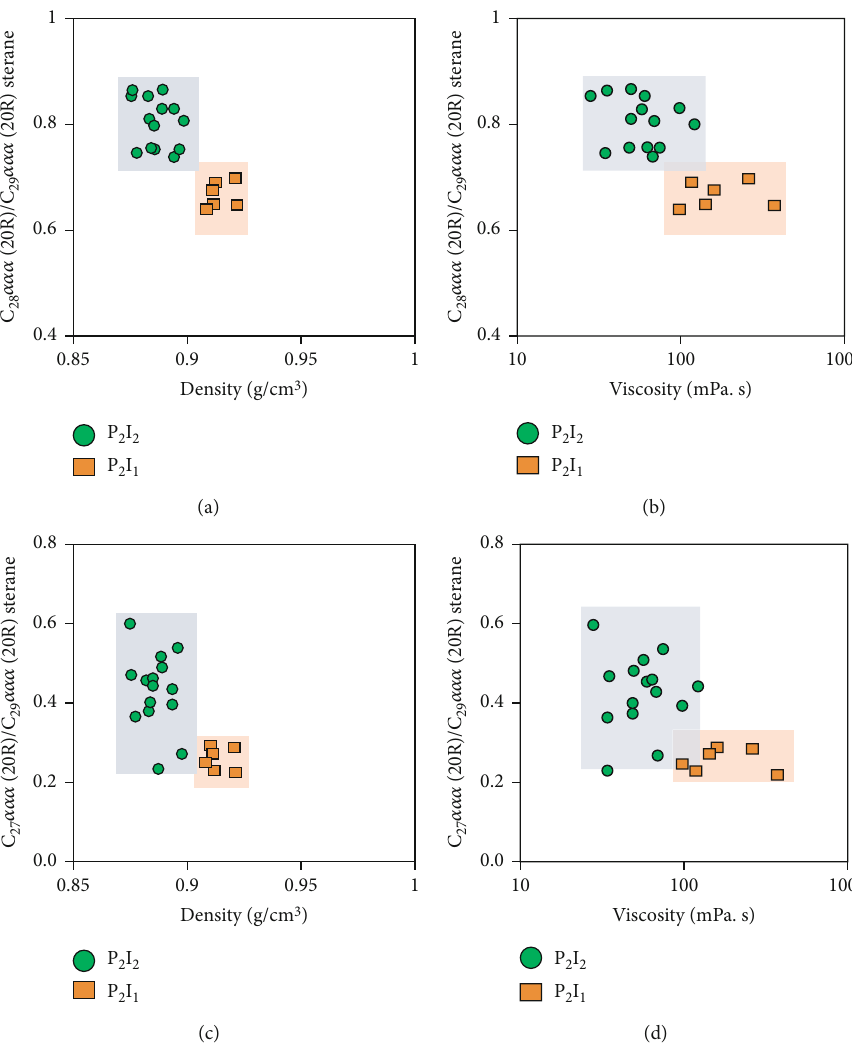
Figure 11: Cross-diagrams of (a) density and (b) viscosity versus ααα -20R C 20R C /C sterane ratio, for the crude oil sample in the Lucaogou 27 29